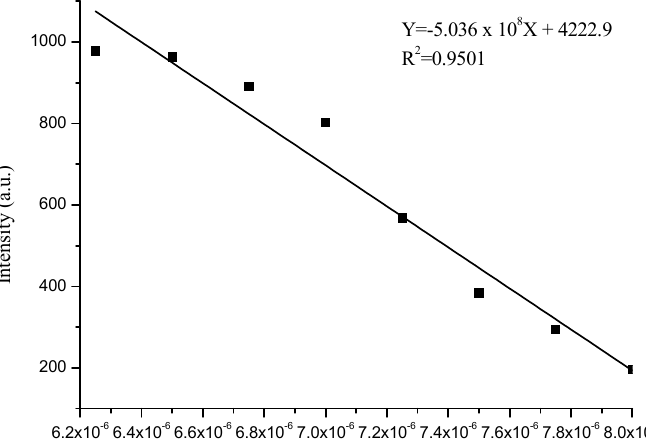
Figure 8. Plot of linear fitting for emission intensity vs. the concentration of Fe 3+